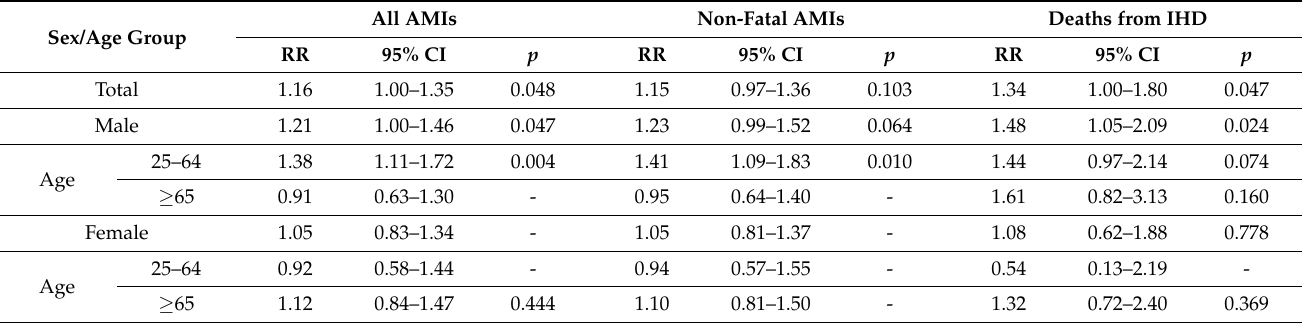
Table 6. The effect of X-class solar flares (days of SFs with a lag of 0–1 day during GSs or SFs 1 day after the period of GSs) on the risk of AMI and the effect of SFs with a lag of 0–2 coincident with days of GSs with a lag of 1 day on deaths from IHD during the whole studied period by sex and age group.